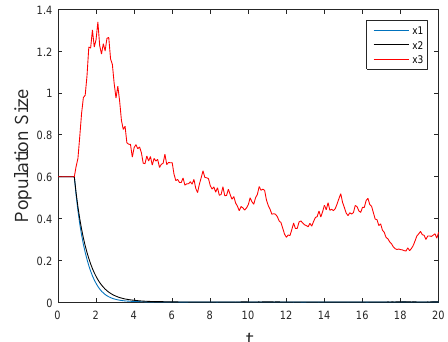
Figure 4. The deterministic system.